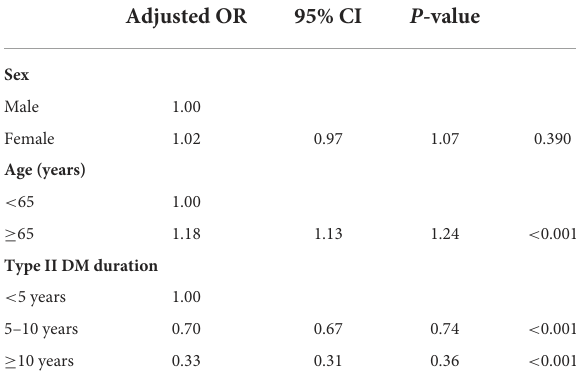
TABLE 4 Risk and protective factor analysis using conditional logistic regression model assessing the influence of age, sex, and DM duration on